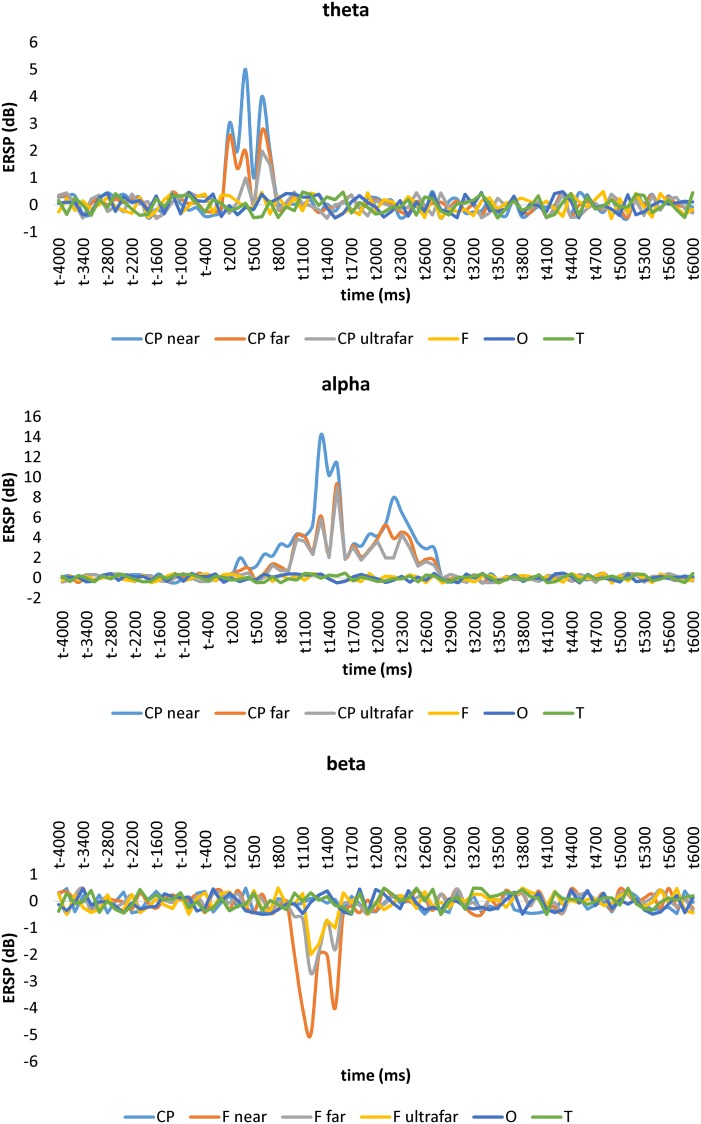
Event-related spectral perturbation (ERSP) time course across hand positions.ERSP are highlighted only for the significant electrode-groups.